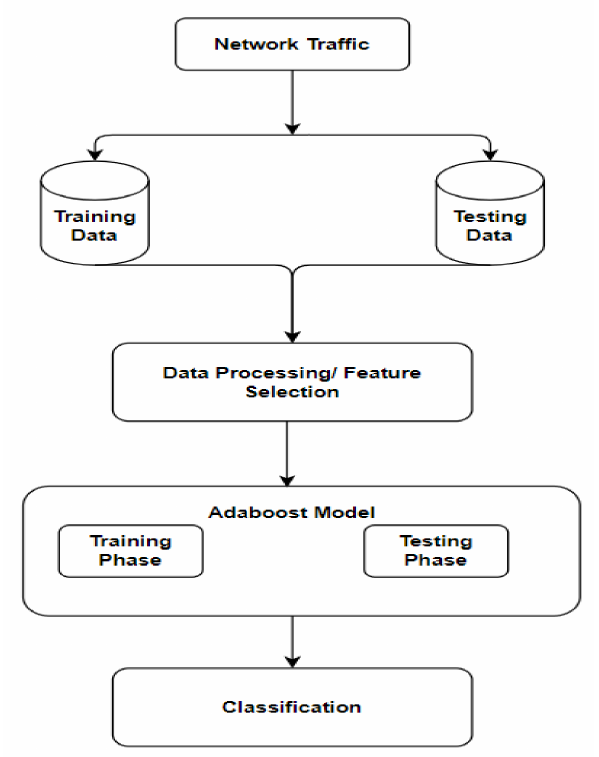
Figure 3. Overall proposed